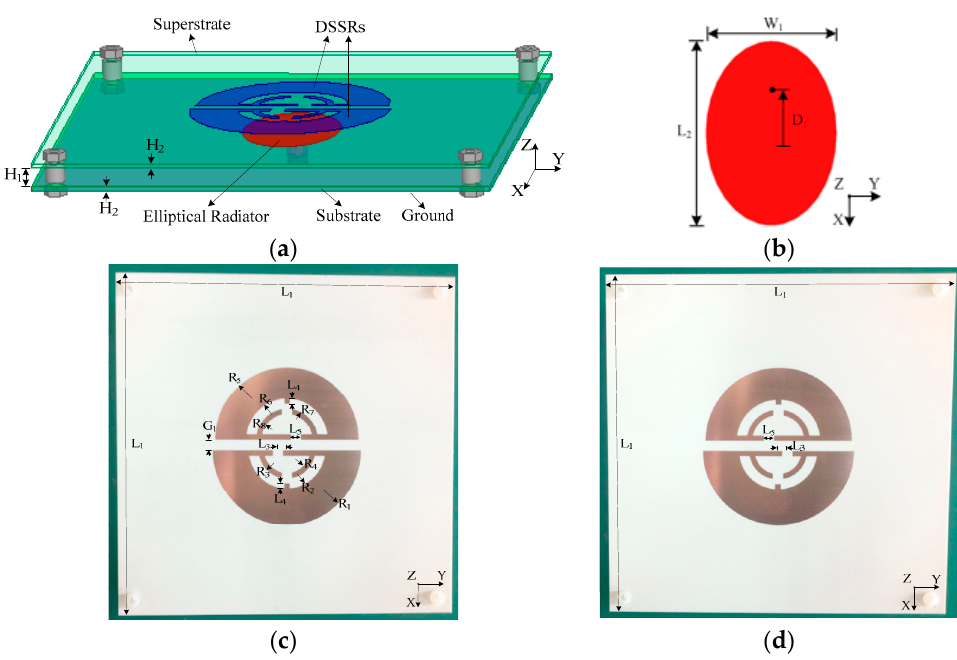
Figure 6. Configuration of the proposed circularly polarized antennas: ( a ) Three-dimensional view; ( b ) elliptical radiator; ( c , d ) are, respectively, the front view of fabrication prototype corresponding to the RHCPA and the LHCPA. Table 1. The dimensions of the proposed antennas shown in Figure 6 (unit: mm).